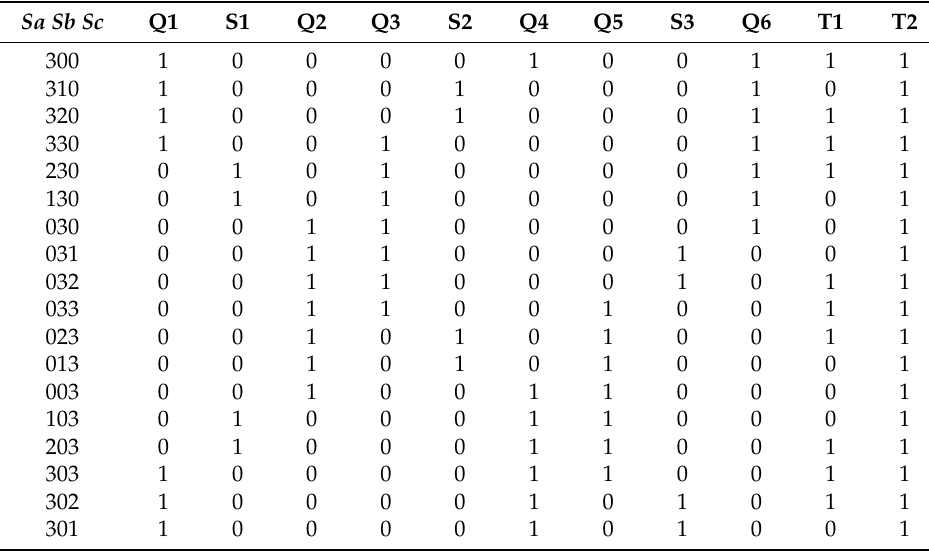
Table 2. Switching sequences for all switches of T-NPP inverter.